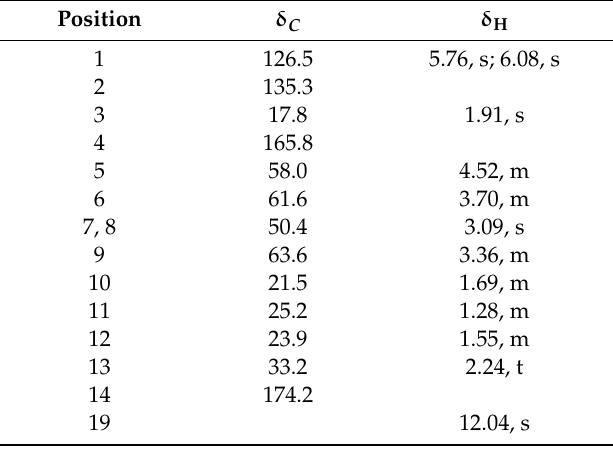
Table 1. NMR spectral peak assignments of AMadh1 structure.